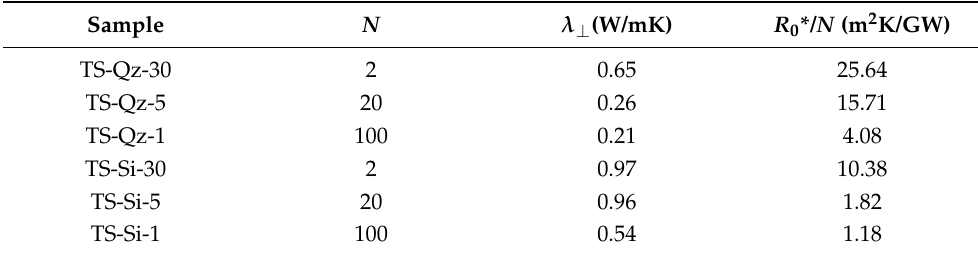
Table 3. Thermal conductivity of the samples. N is the number of the